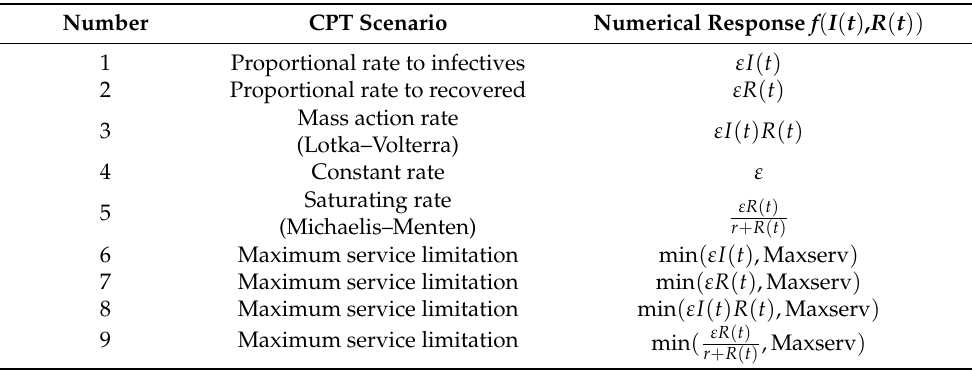
Table 1. Different possible scenarios of CPT